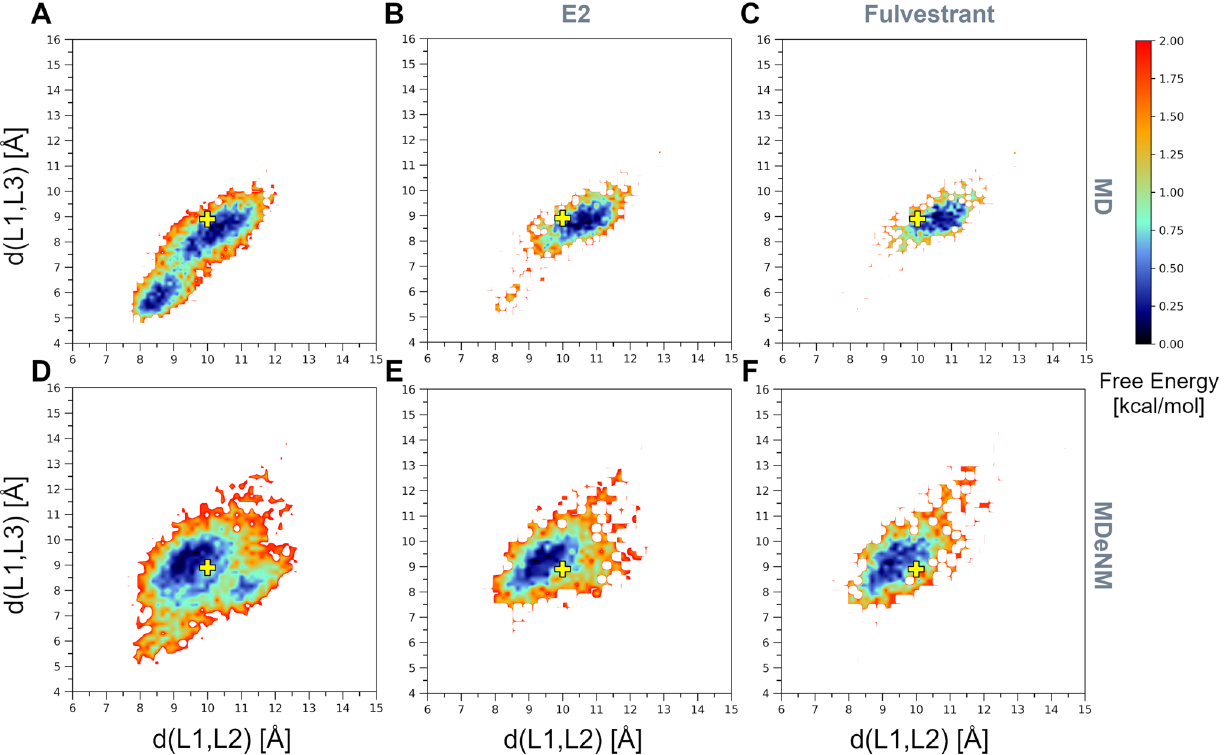
Figure 6. Free Energy Landscapes (FELs) in the space defined by the distances d(L1,L2) and d(L1,L3) of ( A ) the MD generated structures, ( B ) MD structures capable of accommodating competent E2 orientations, ( C ) MD structures capable of accommodating competent fulvestrant orientations; ( D ) the MDeNM generated structures, ( E ) MDeNM structures capable of accommodating competent E2 orientations, and ( F ) MDeNM structures capable of accommodating competent fulvestrant orientations. The initial crystal structure (4GRA. pdb) is denoted by yellow ‘ + than 5 Å. Although it has been shown that the formation of fulvestrant-3-sulfate/estradiol-3-sulfate is preferable, it is also possible that low levels of fulvestrant-17-sulfate/estradiol-17-sulfate are produced 43 . The distribution of conformations capable of accommodating E2 and fulvestrant, along the formerly defined distances d(L1,L2) and d(L1,L3), is shown in Fig. 5. MD and MDeNM conformations were capable of accommodating E2, regardless of their openness (Fig. 5B and E), which agrees with previous kinetic and binding studies showing that E2 can bind to open and closed conformations of SULT1A1 23 . The analysis of the conformations showing the strongest BEs (having a BE to estradiol lower than − 10 kcal/mol; denoted by blue ‘x’) further indicates that the extremely closed state is mostly unfavorable even for estradiol binding. This is in line with the fact that E2 is a medium- size substrate of SULT1A1. Fulvestrant showed, even more, an obvious preference towards open conformations. Similarly to MD, as mentioned above, the opening along d(L1,L2) and d(L1,L3) is restricted by the high correla- tion between them; hence opening along both distances is required for fulvestrant to dock (Fig. 5C). MDeNM results reveal, however, that the opening along d(L1,L3) rather than d(L1,L2) is essential for fulvestrant (Fig. 5F). Analysis of the best docking results of fulvestrant (having a BE lower than − 10 kcal/mol; denoted by blue ‘x’) further confirmed that only conformations with a great d(L1,L3) distance are favorable for fulvestrant docking. MDeNM simulations were capable of generating widely open conformations accessible for fulvestrant, 3 Å along d(L1,L3) beyond MD conformations. Both MD and MDeNM results confirm that, open conformations are still available for big ligands to bind even with the co-factor bound. The distribution of conformations shown in Fig. 5 were also transformed in Free Energy Landscapes (FEL) according to Eq. 1 (see “Materials and methods”) and are shown in Fig. 6. Interestingly, most of the conformations capable of accommodating competent E2 and fulvestrant are of low free energies. An example of a favorable position of E2 docked into an MDeNM generated conformation (Fig. 7) illustrates the excellent superposition to the bioactive conformation of E2 in the structure of SULT1A1*2 co-crystallized with E2. Figure 8 shows competent docking positions of fulvestrant in three MD and three MDeNM generated conformations. Their comparison with the crystal structure of apo SULT1A1*1 (PDB ID 4GRA) demonstrates the utility of using MDeNM simulations, suggesting a larger opening of the pore than observed by the MD simulations and facilitating thus the accommodation of large substrates as fulvestrant. Further MD simulations were performed for SULT1A1/PAPS bound to a substrate. The best-docked struc- tures for the two substrates E2 and fulvestrant, having the best docking scores and competent positions, were chosen as starting structures for the additional MD simulations. Two docked positions of E2 were chosen, one in an MD—and one in an MDeNM—generated conformations (shown in Fig. 7). For the fulvestrant, three and three starting positions were chosen out of the MD- and MDeNM—generated conformations, respectively (shown in